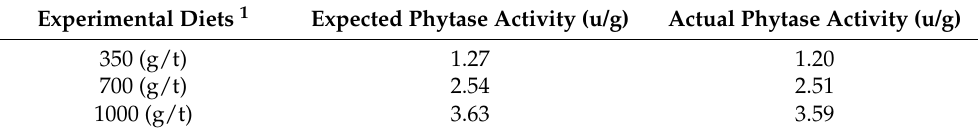
Table 2. Expected and actual (analysed) phytase activity of experimental